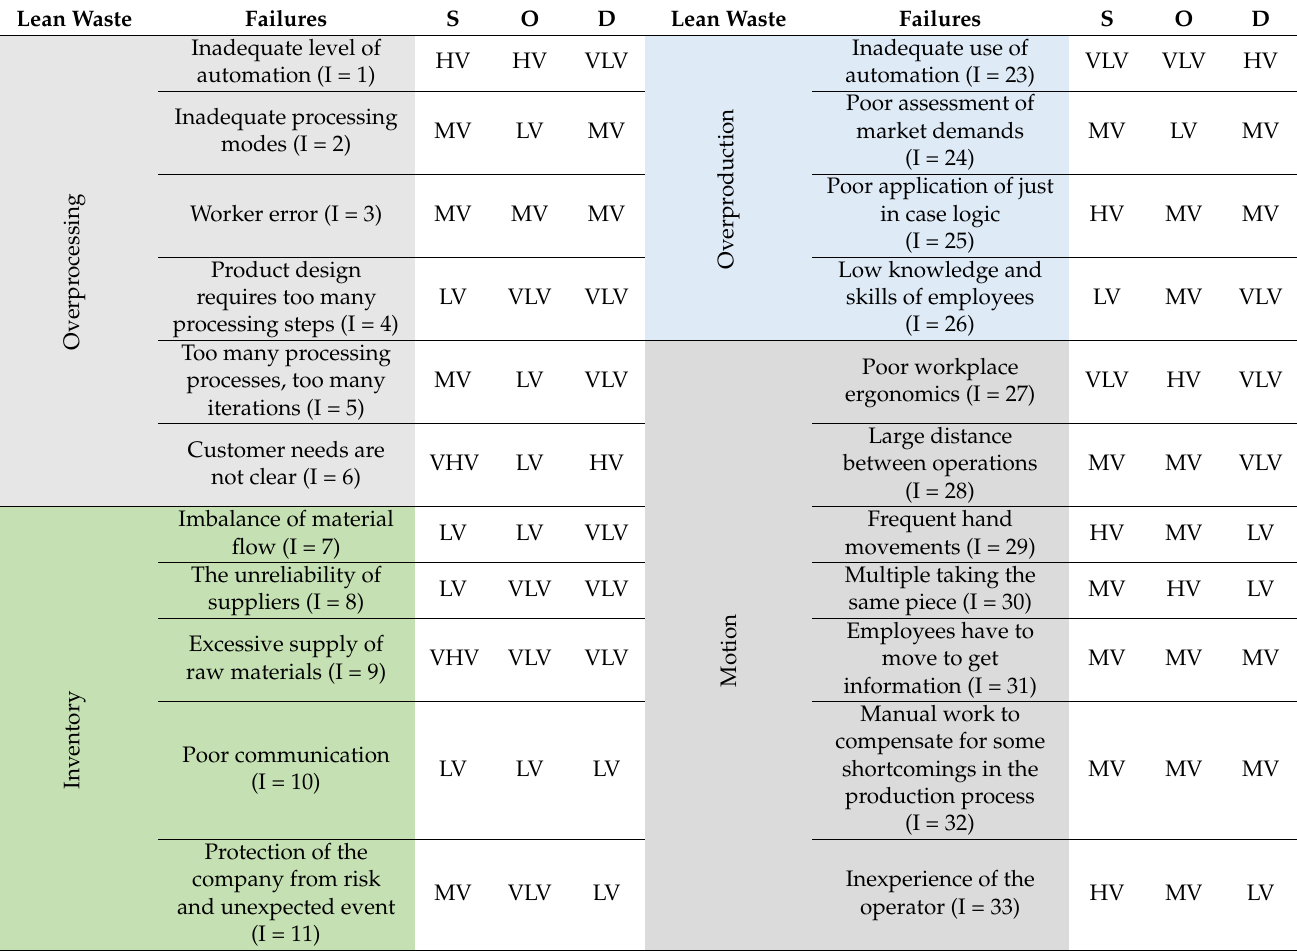
Table 5. Fuzzy rating of the relative importance of